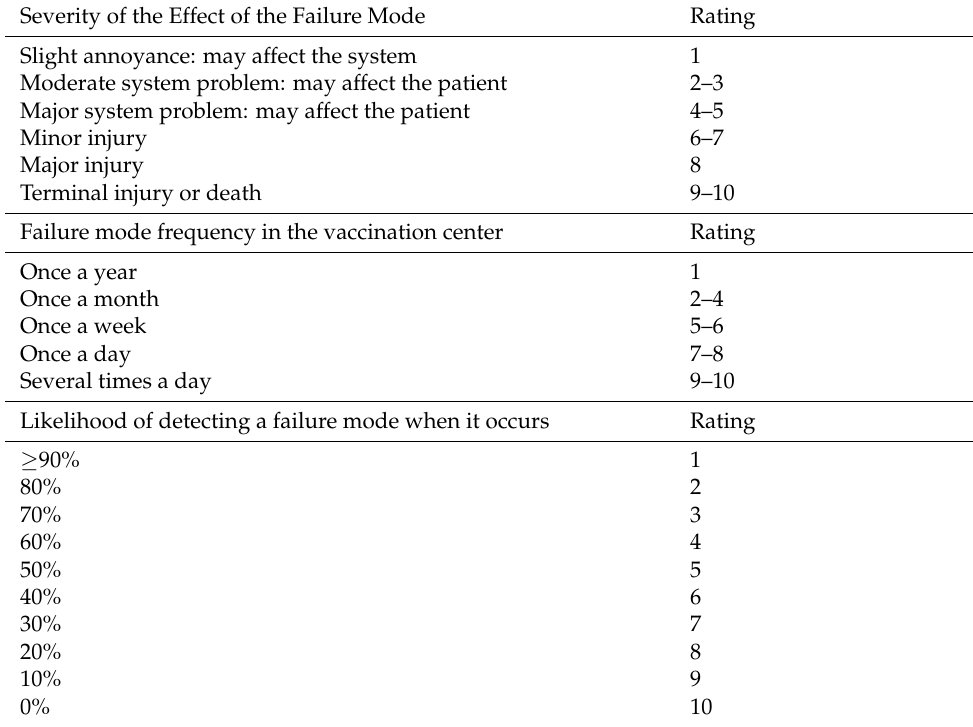
Table 1. Rating scales for severity, frequency and likelihood of